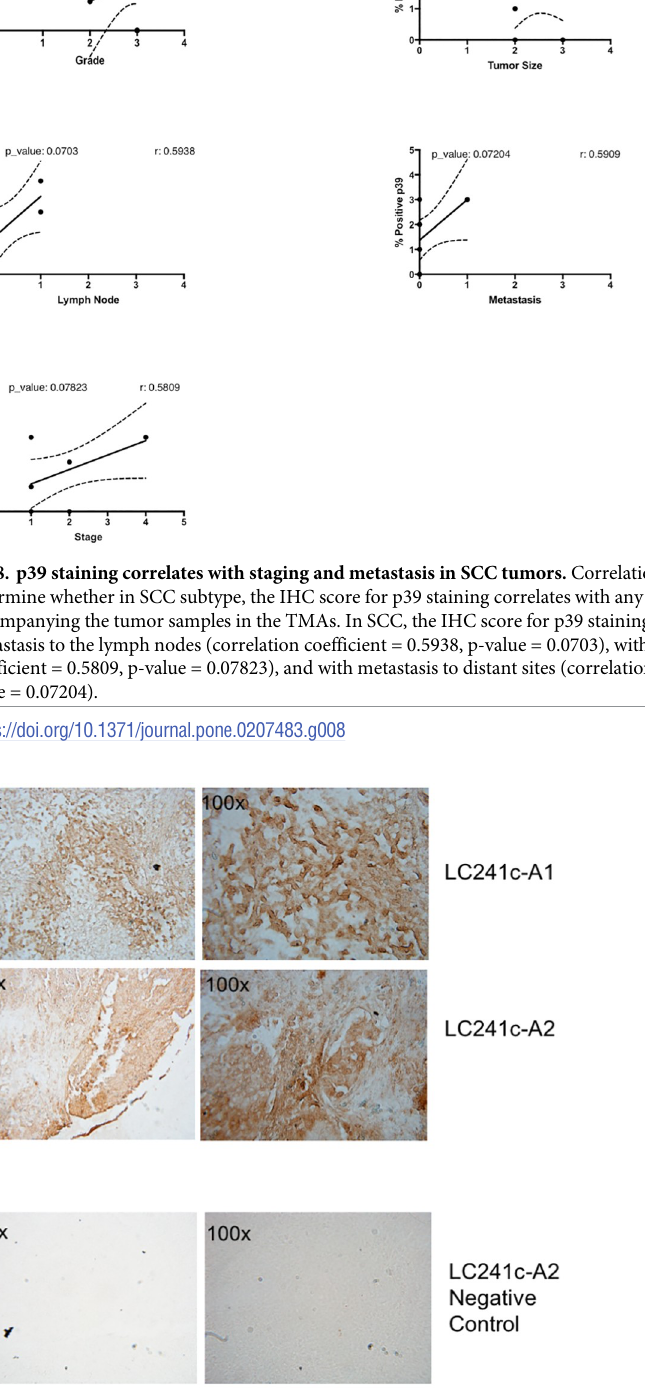
Fig 9. Strong p39 staining is observed in metastatic tumors. Strong p39 IHC staining of SCC tissue cores LC241c-A1 and LC241c-A2 from stage 4 patients with both lymph node and distant metastases. These cores have a p39 staining score of 3, a strong phospho-Rb S249 staining and a grade of 3. The two panels at the bottom illustrate negative controls (no primary antibody) of the LC241c-A2